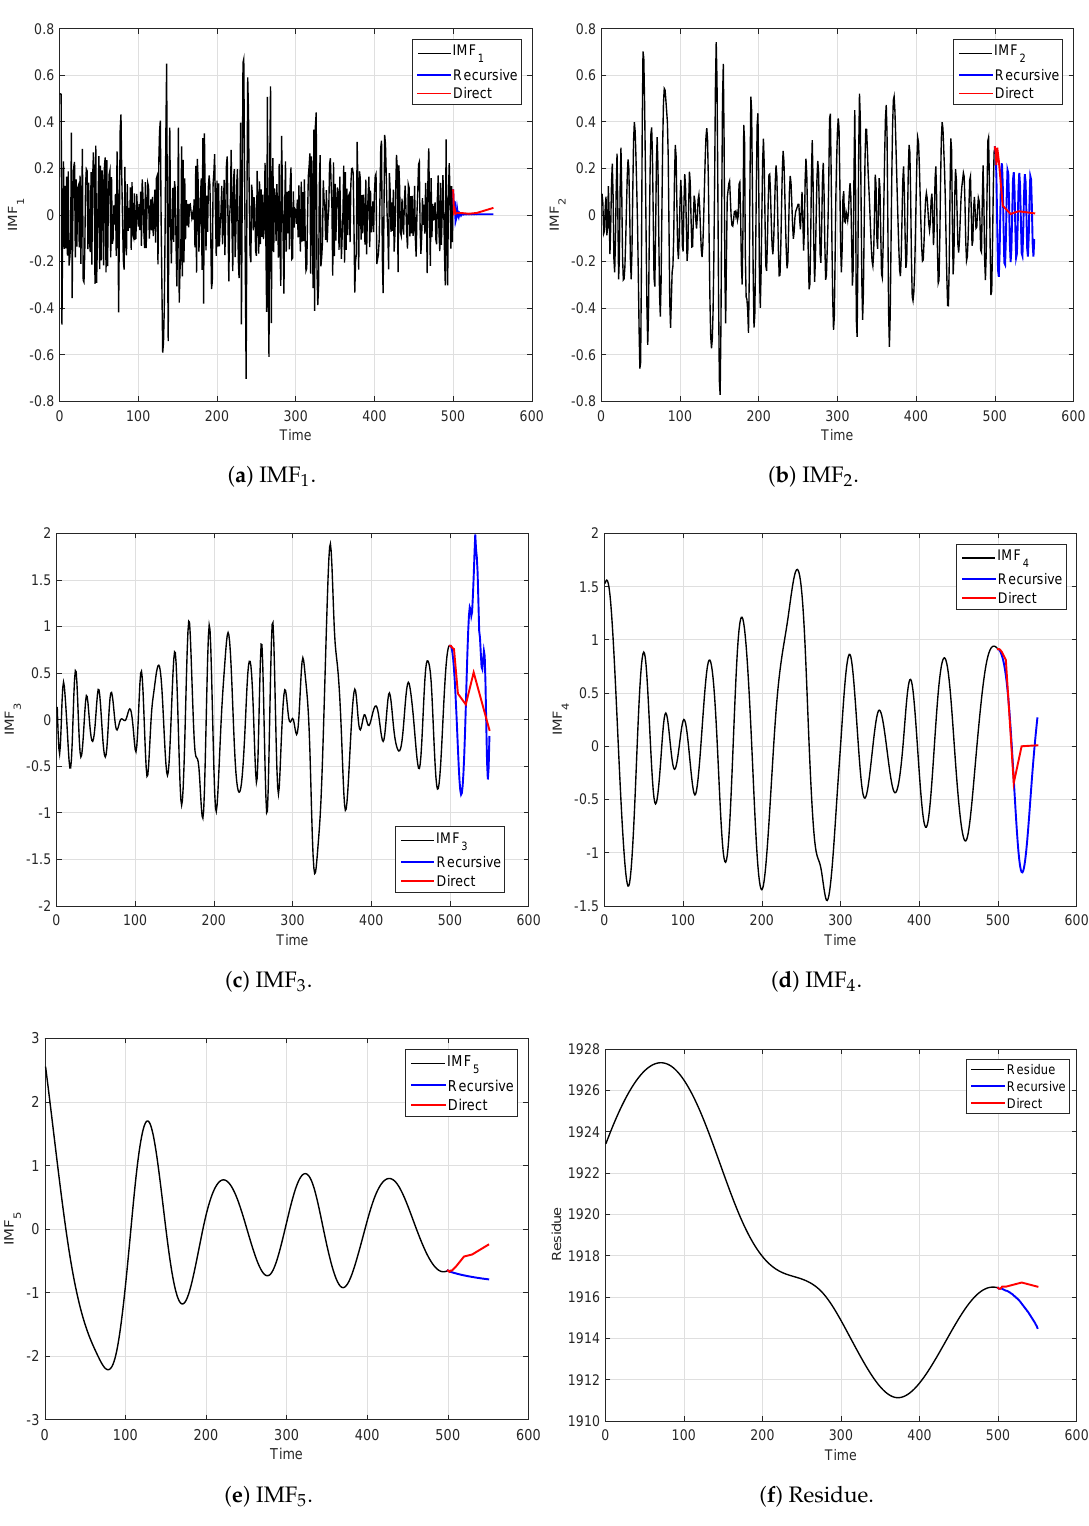
Figure 2. True (black lines) and forecasted (red and blue lines) intrinsic mode functions (IMFs) and residue extracted from the S&P 500 index for 7 August 2014 shown in Figure 1. The forecasted values were obtained using the univariate empirical mode decomposition–support vector regression (EMD–SVR) model, using both the recursive (blue line) and the direct strategies (red line). We note that the black lines end when forecasting begins. EMD was performed on the training set